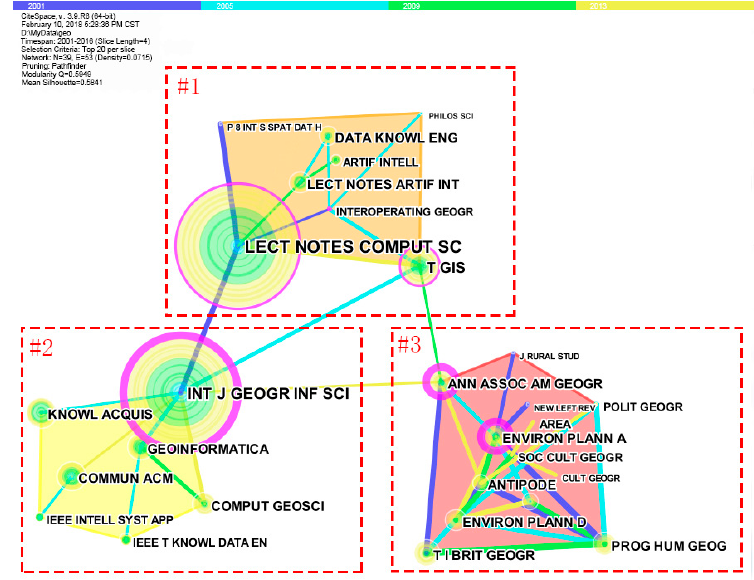
Figure 3. Cluster network of journal co-citations for 39 documents and 53 links.